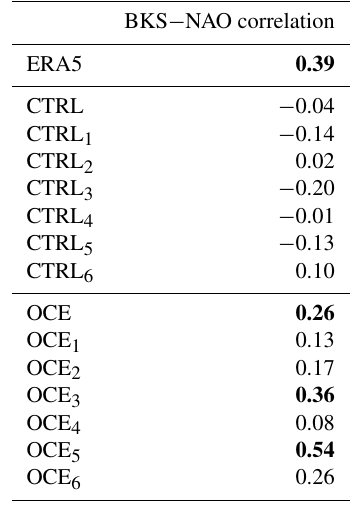
Table 1. Correlations between anomalies in the November Barents– Kara sea ice concentration and the DJF NAO mean, over the period 1980–2015, for each data set. Subscript labels CTRL n and OCE n ( N = 35) denote ensemble members 1–6, while the entry for CTRL and OCE ( N = 210) uses the concatenated time series. Entries that are significant ( p < 0 . 05) are marked in bold. Significance is mea- sured against a null hypothesis of uncorrelated, random AR1 pro- cesses. BKS − NAO correlation